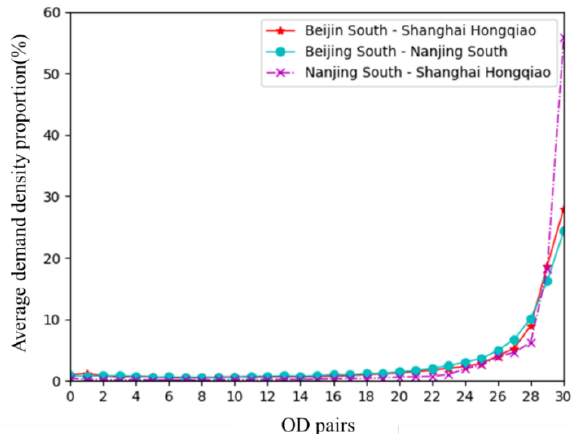
Figure 5. Average demand density proportion of several OD pairs.